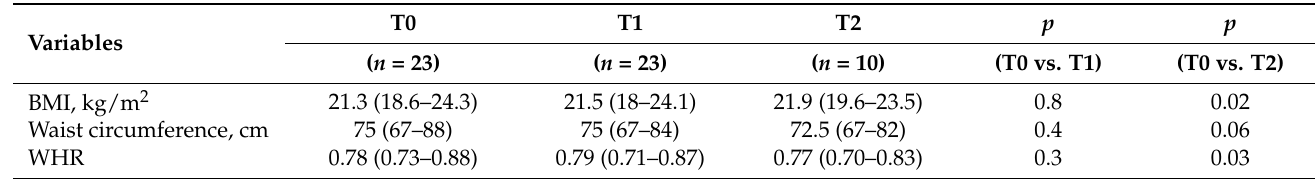
Table 3. Anthropometric parameter changes in women with normal BMI.